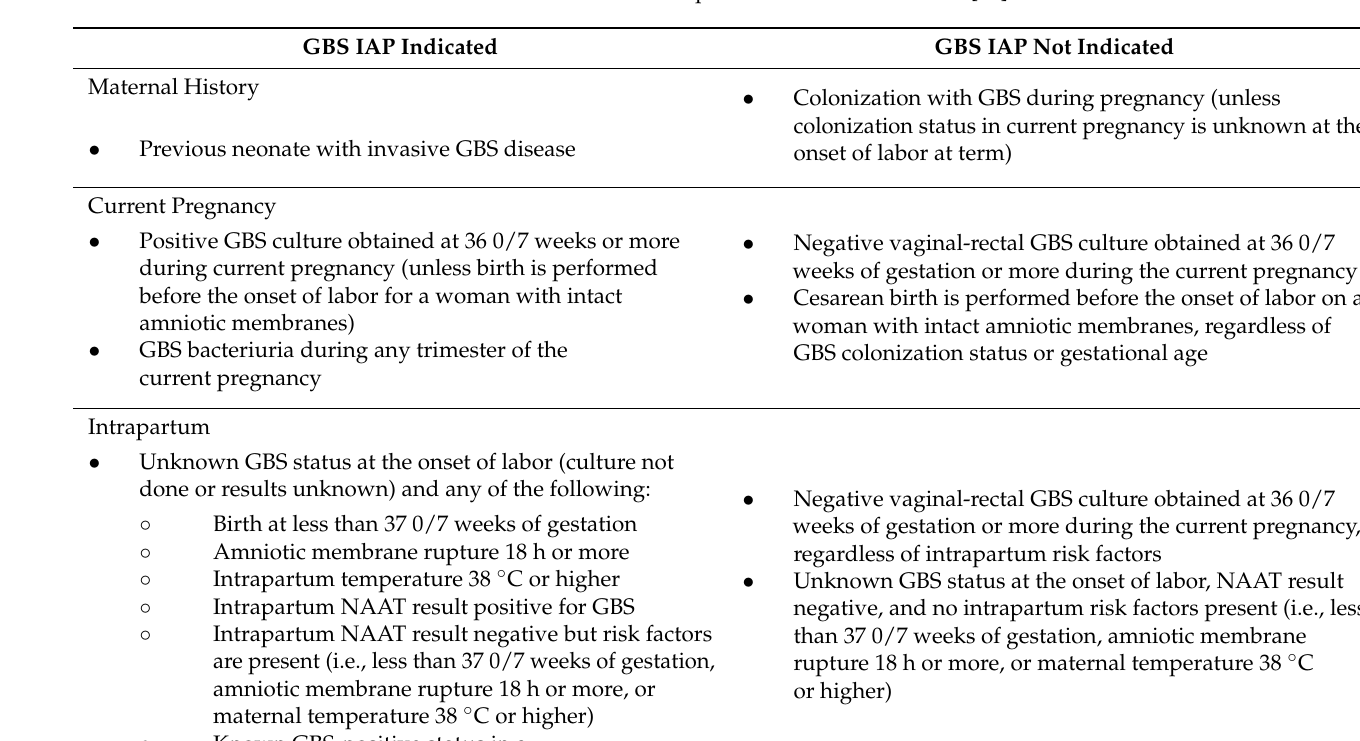
Table 1. Indications of IAP to prevent neonatal GBS EOD [26].